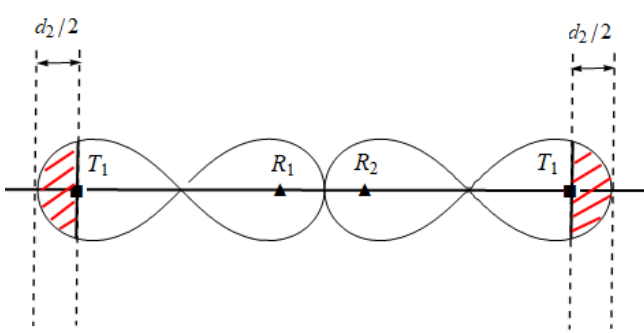
Figure 8. The maximum placement spacing sequence in external coverage area of sequence T 1 − R n − T 1